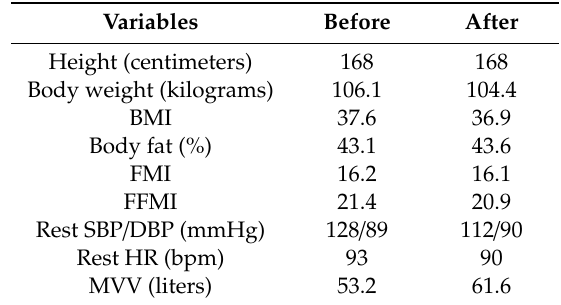
Table 1. Body composition before and after exercise training